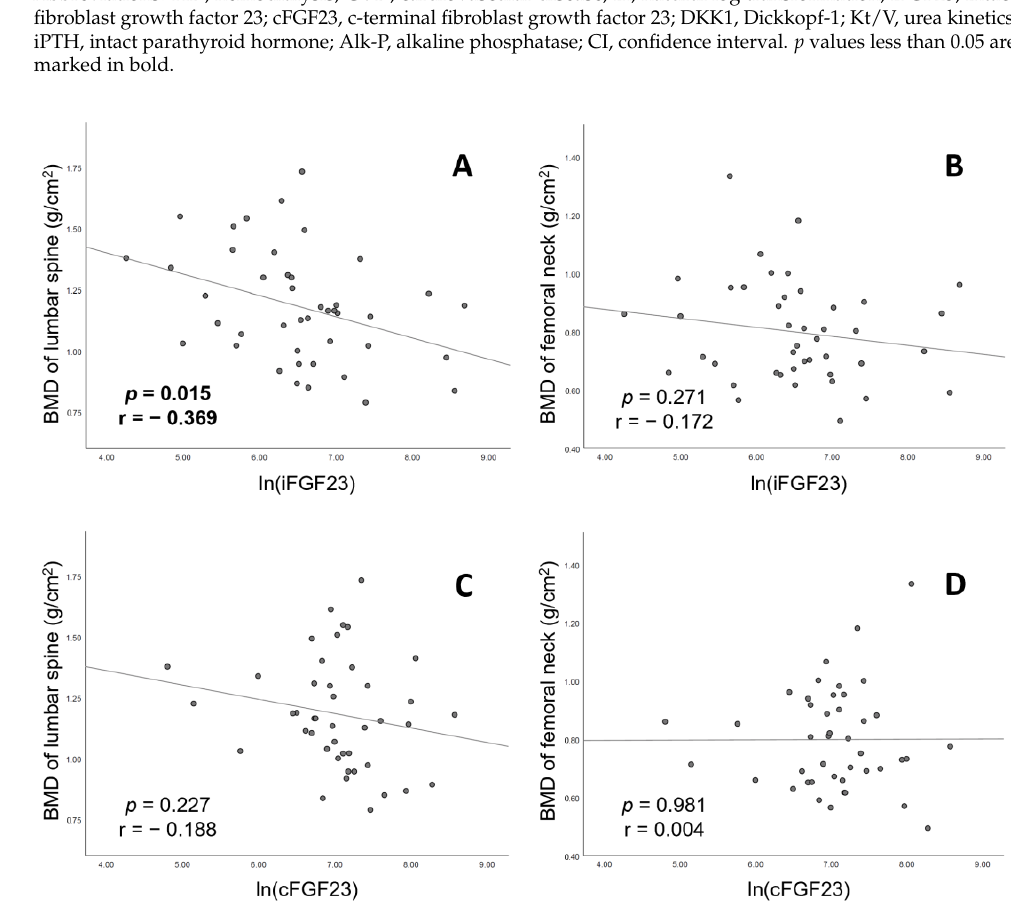
Figure 4. Ln(iFGF23) versus bone mineral density (BMD) levels of ( A ) lumbar spine and ( B ) femoral neck (bilateral). Ln(cFGF23) versus BMD levels of ( C ) lumbar spine and ( D ) femoral neck. The regression lines in the figure are based on the least mean squares method.